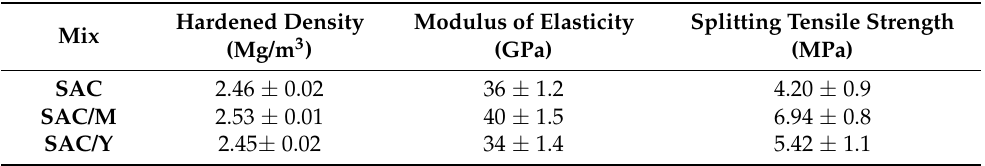
Table 6. Hardened properties (mean value and standard deviation).